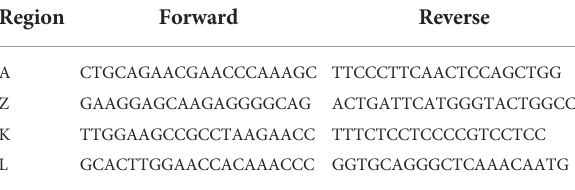
TABLE 1 Primer sequences for ChIP-qPCR studies of the GILZ